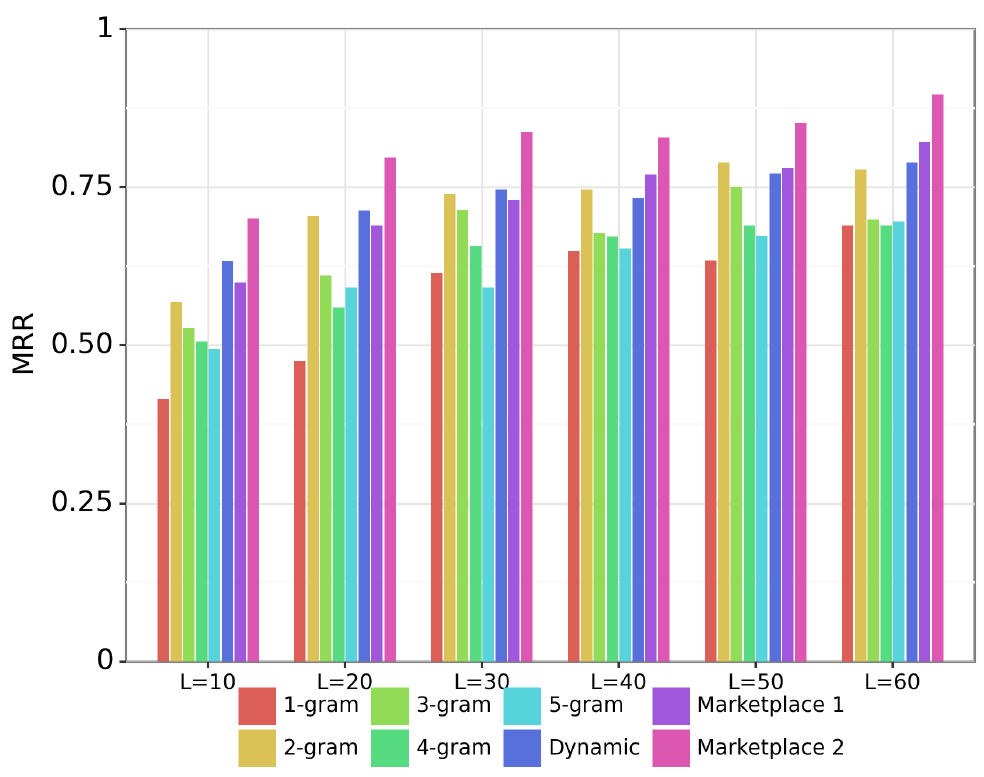
Figure 4. Experimental results on the MIDI-based sheet music retrieval task. Each query is a MIDI fragment of duration L seconds. Results are shown for the marketplace system with two different feature representations: a bootleg score with duplicated notes in the middle register (“Marketplace 1”) and a bootleg score where notes in the middle register are classified into left- and right-hand staves (“Marketplace